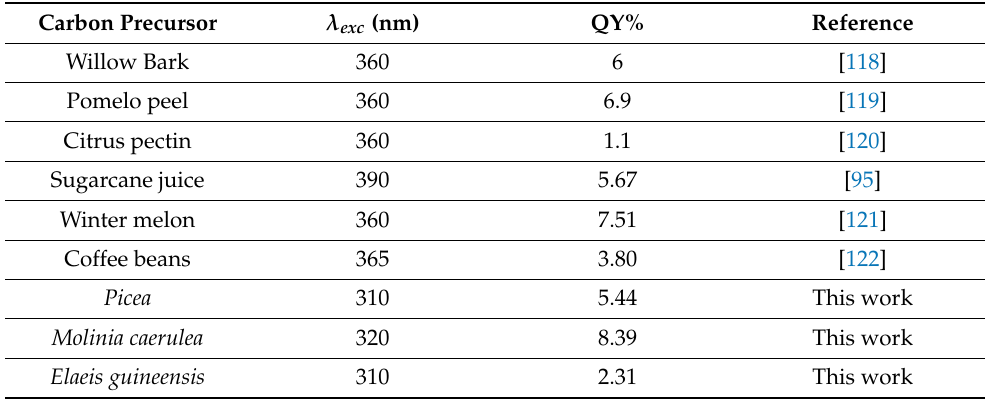
Figure 5. UV-Vis spectra of Picea, Molinia caerulea, and Elaeis guineensis C-Dots. The Quantum Yields (QY) of the Picea , Molinia caerulea and Elaeis guineensis C-Dots were 5.44, 8.39, 2.31% respectively, using quinine sulfate (QY of 0.54 in 0.5 M H 2 SO 4 [105]) as the reference. Table 2 shows the comparison of several biomass-derived C-Dots QYs and excitation wavelengths with the results obtained in this work. Moreover, for C-Dots derived from biomass using the hydrothermal method, the QYs can range from 2.3% to 21.7% depending mostly on its size, carbon precursor, and processing parameters [106–108]. It is suggested that the high quantum yield obtained for the C-Dots synthesized from Molinia caerulea , is because the biochar from this source is one with the highest nitrogen and sulfur content (Table 1), compared to Picea and Elaeis guineensis , which influence the production of C-Dots with heteroatoms and are related to the increase in fluorescence intensity and its quantum yield [109–111]. For instance, Zhu et al. [99], obtained C-Dots doped with nitrogen and synthesized from citric acid and ethylenediamine with a QY of 80%. Likewise, several authors have shown an increase in the QY of C-Dots through doping with nitrogen or sulfur heteroatoms [112–117]. Table 2. Comparison of several hydrothermally produced C-Dots with different biomass